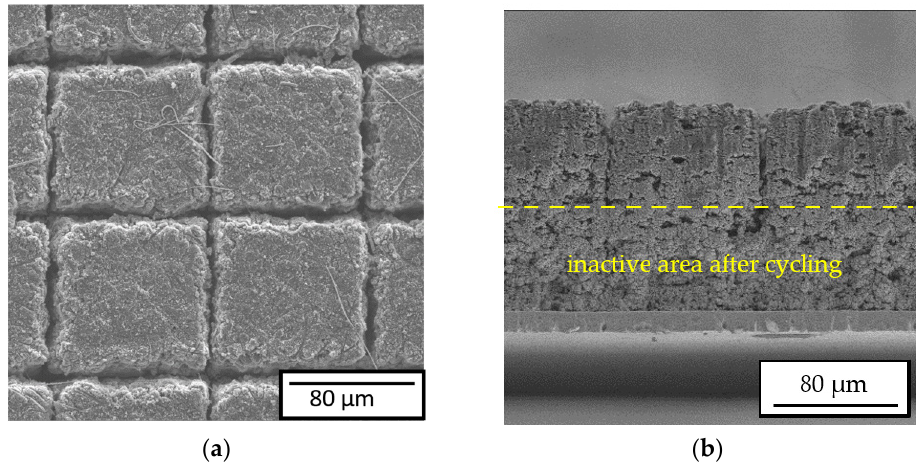
Figure 10. SEM images of cycled Si/C electrodes: ( a ) top view and ( b ) cross-sectional view.